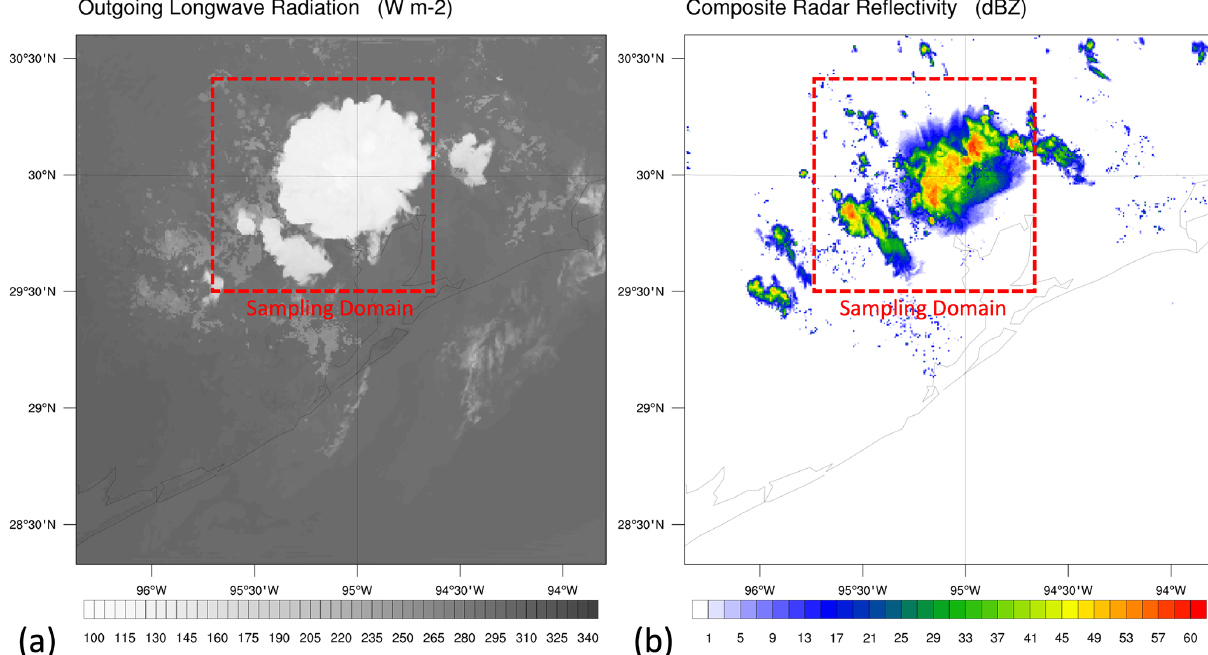
Figure 1. NU-WRF domain and sampling domain showing (a) outgoing longwave radiation (OLR) and (b) composite radar reflectivity, on 19 June 2013 at 23:25UTC, for the simulation with an aerosol number concentration of 500cm − 3